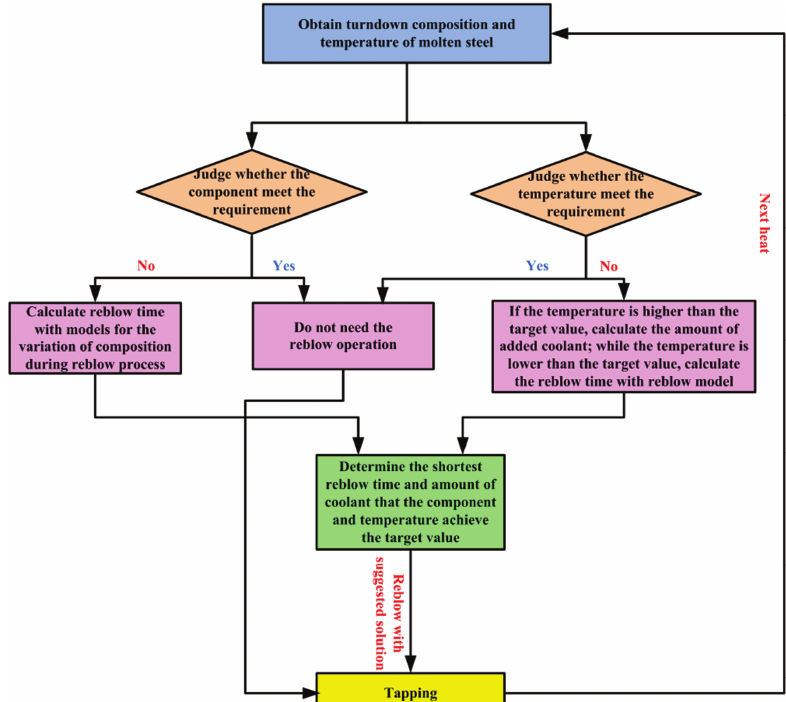
Figure 4: Calculation diagram of the solution for reblow